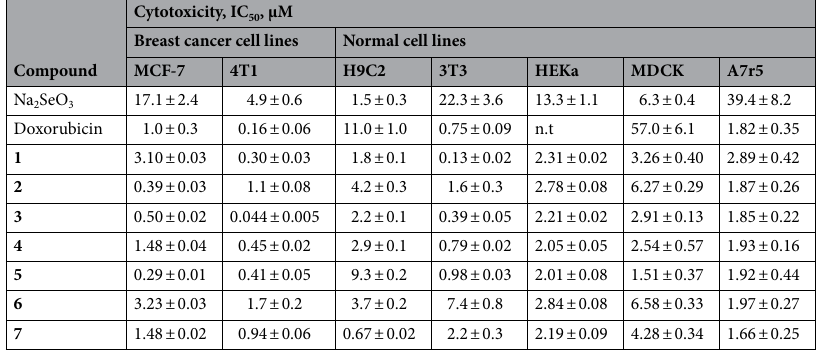
Table 1. Cytotoxic activity of 1 – 7 against breast tumor and normal cell lines. Values are shown as the means ± S.D. from 3 independent experiments. nt, not